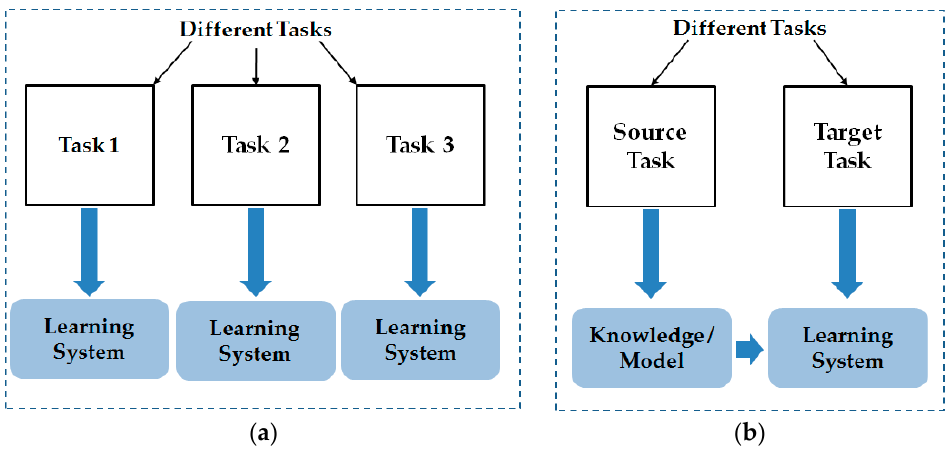
Figure 3. Demonstration of the difference between: ( a ) traditional machine learning technique; and ( b ) transfer learning technique.